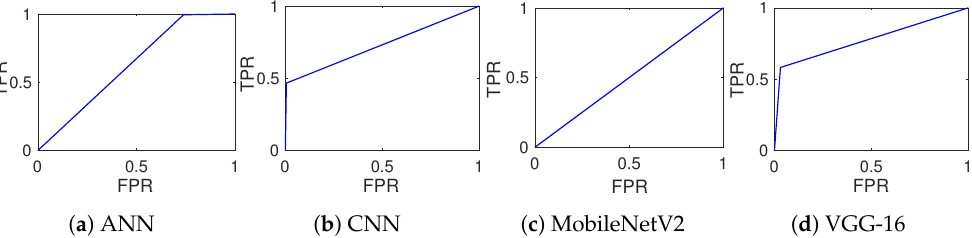
Figure 6. Models ROC on Pest pattern classification. (TPR = True positiver rate, FPR = False positive rate).